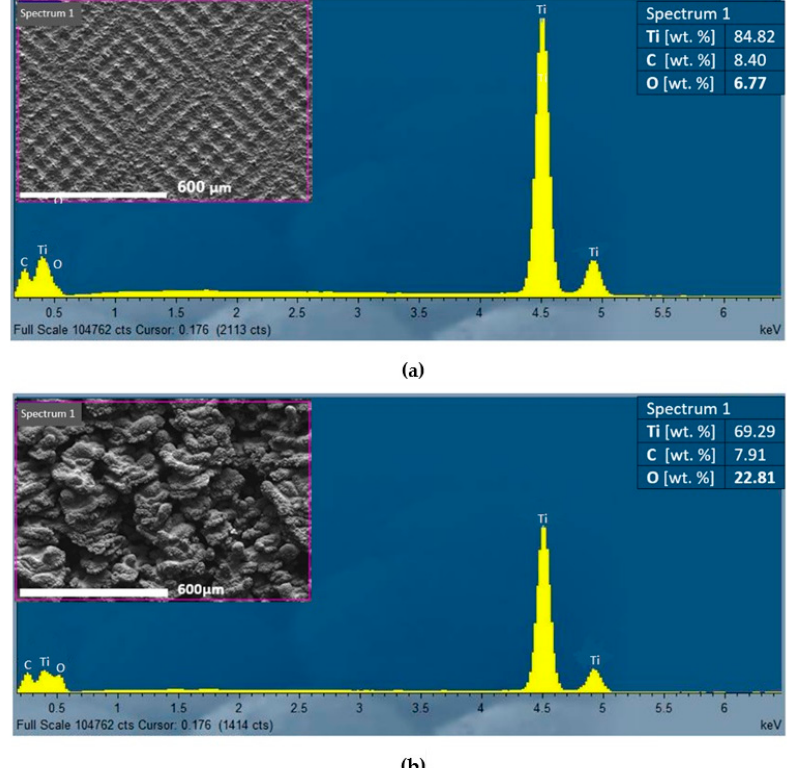
Figure 10. Results of EDS analysis: ( a ) surface S1 (E T = 0.5 mJ, E p = 0.2 mJ, D L = 100 µm), ( b ) surface (E T = 500 mJ, E p = 1 mJ, D L = 0.5